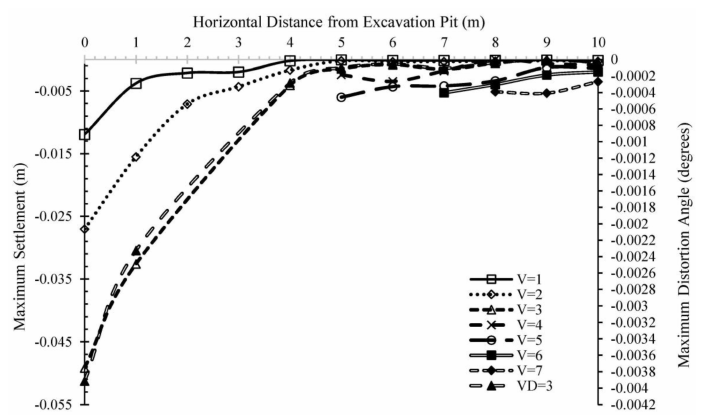
Fig. 6. Settlement at Point B and Angle of Distortion for Scenario 2